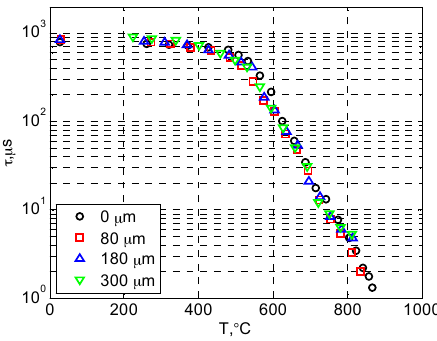
Figure 6. Calibration results of Dy-doped TBC with different topcoat thickness.